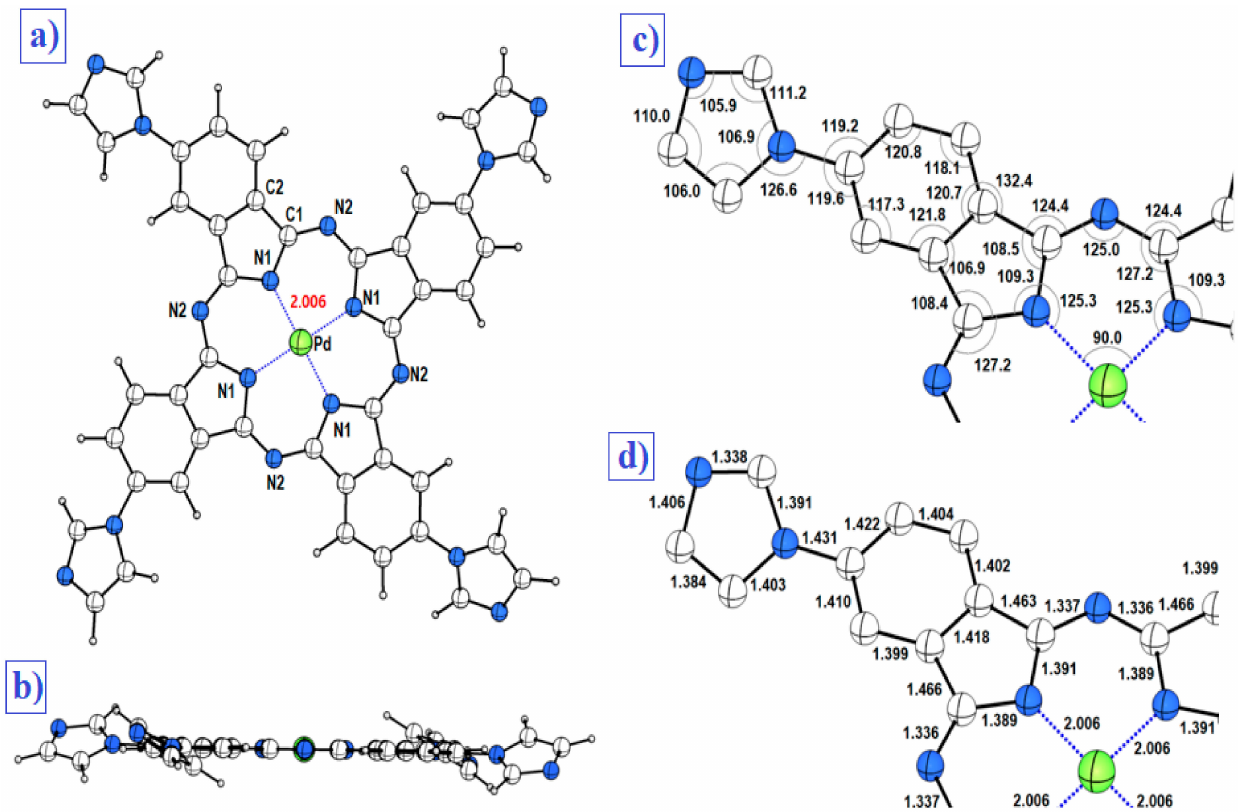
Figure 1. ( a ) Chemical structure of the singlet stat of the neutral PdPc(Im)4 Ci symmetric molecule calculated at the B3LYP-D3/SDD level of theory, taking into account the effect of the DMSO solvent with the SMD model, ( b ) plan structure of the optimized PdPc(Im)4 molecule, ( c ) distances in Å on a quarter (1/4) magnification of the PdPc(Im)4 molecule (all hydrogen atoms have been omitted for clarity of the figure), and ( d ) angles between atoms in degrees represented on a quarter of the molecule for more clarity (all hydrogen atoms have been omitted for clarity of the